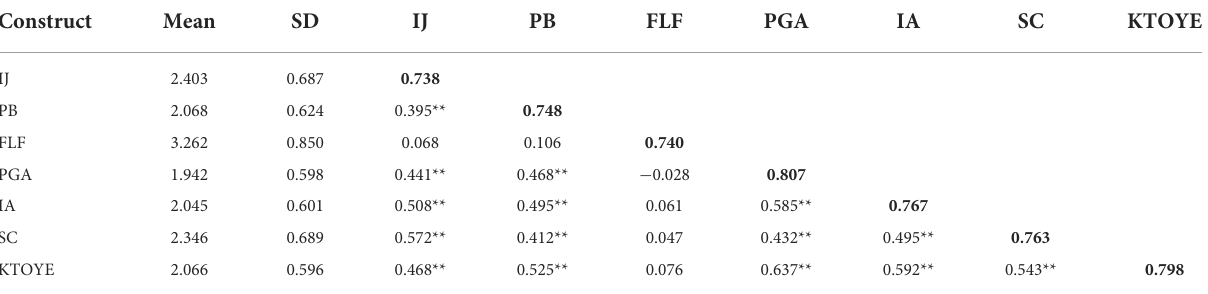
TABLE 4 Descriptive statistics and correlation matrix.